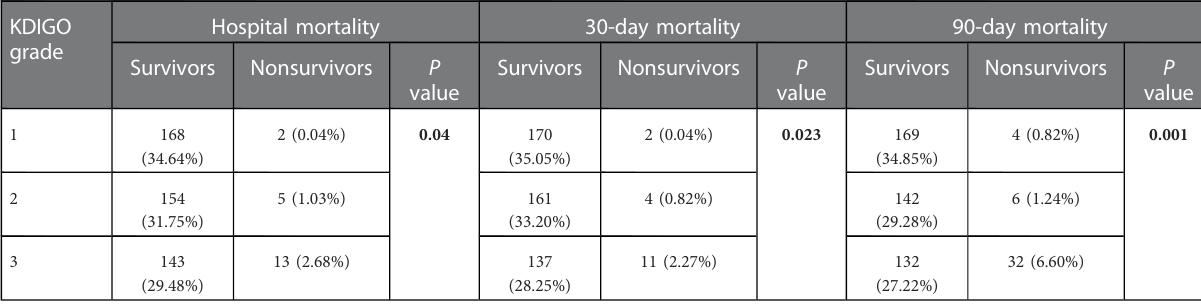
TABLE 5 The relationship between KDIGO grade with mortality for cardiac surgery patients with AKI. KDIGO